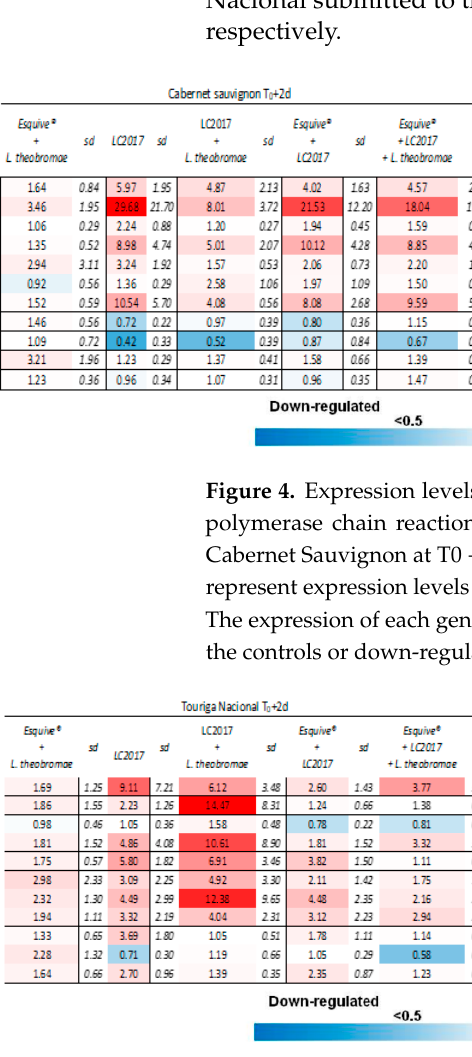
Figure 5. Expression levels of selected genes (determined with quantitative reverse-transcription polymerase chain reactions) and relative standard deviation values (sd) recorded on leaves cv Touriga Nacional at T0 + 2d and T0 + 5d. The values (each the mean of three technical replicates) represent expression levels ( ΔΔ Ct) of treatments relative to the control (condition Esquive ® T0 + 2d). The expression of each gene was considered up-regulated when the value was >2-fold compared to the controls or down-regulated when the value was <0.5-fold compared to the